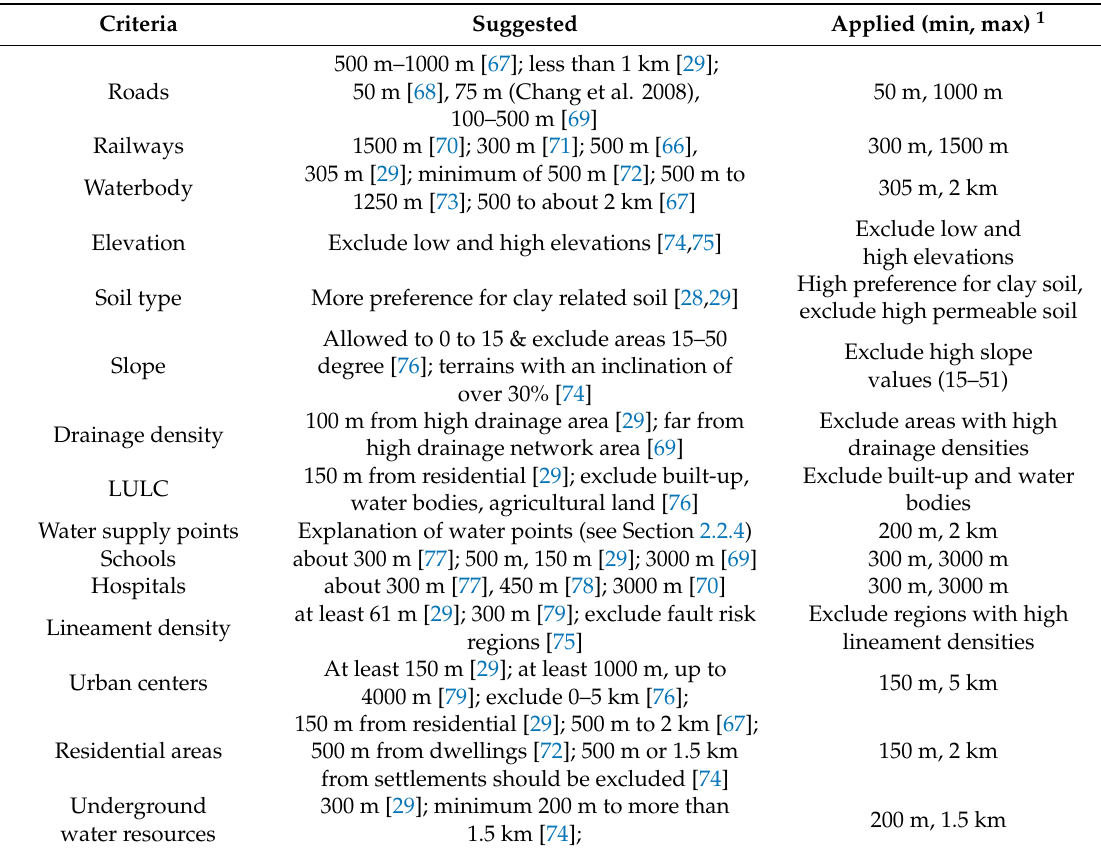
Table A1. Landfill constraints’